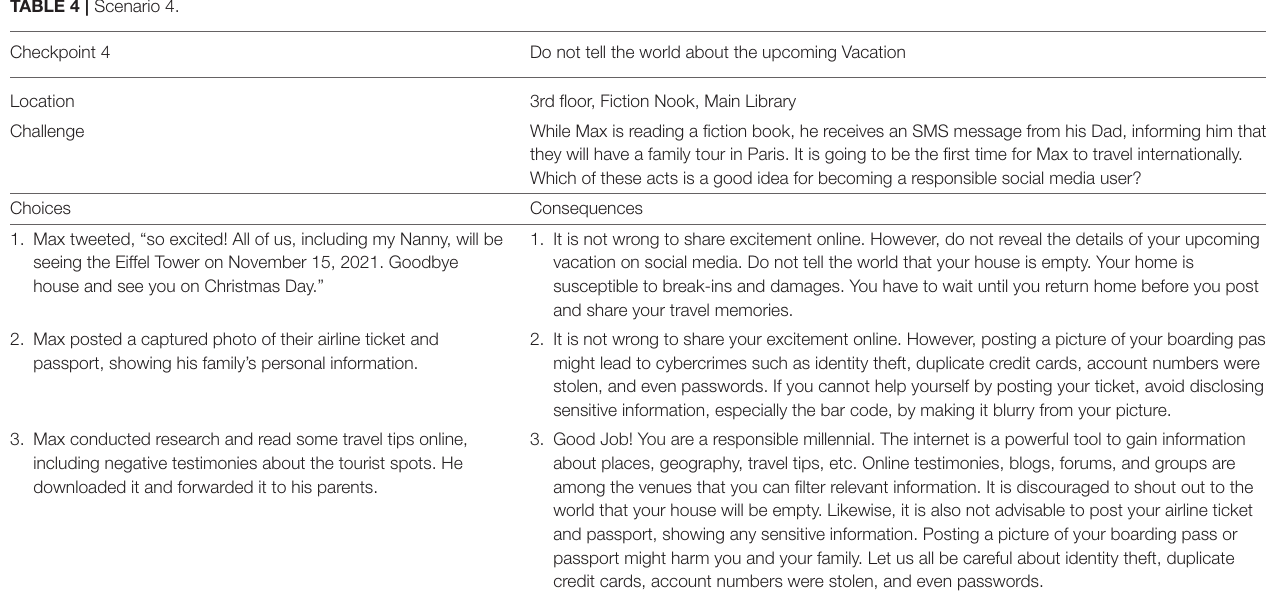
TABLE 4 | Scenario